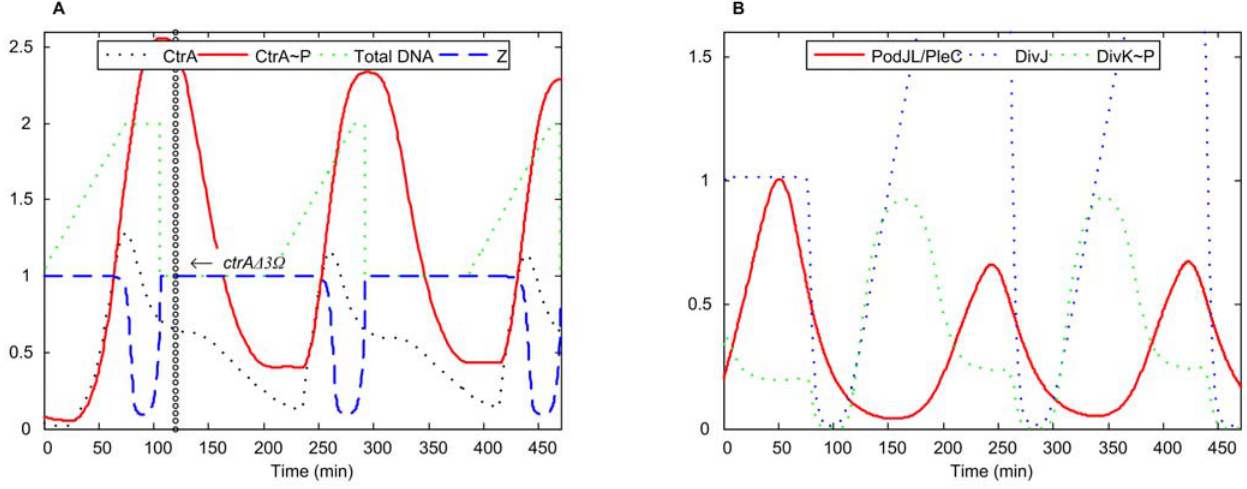
Figure 6. Simulation of ctrA D 3 V mutant. k d,ctrA2 =0.0375 (15% of WT).